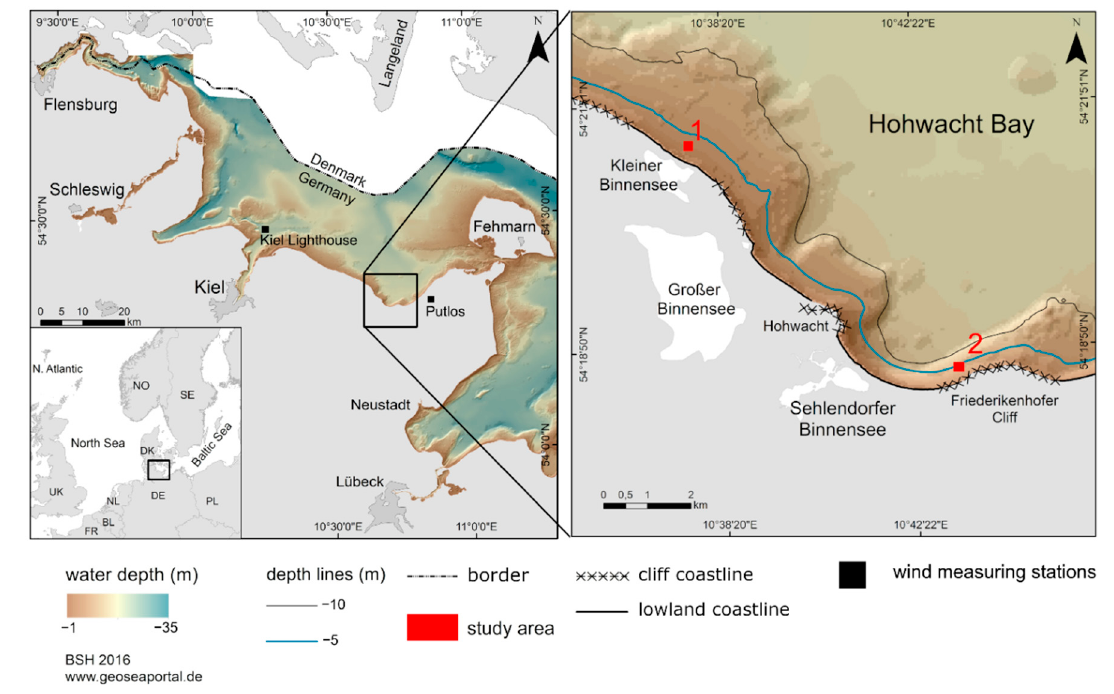
Figure 1. Bathymetric map of the southwestern Baltic Sea including the study areas (Bathymetric data provided by BSH (www.geoseaportal.de) (Accessed on: 20 August 2019).